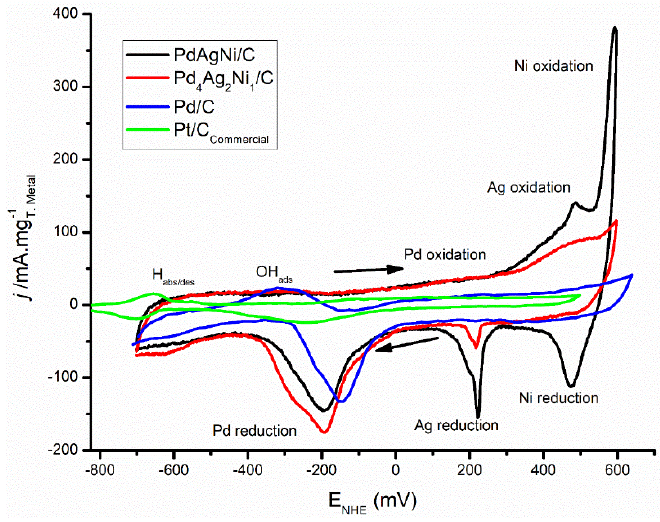
Figure 6. CV voltammograms of Pd/C, Pd 4 Ag 2 Ni 1 /C, and PdAgNi/C in 1M KOH at 50 mV/s.